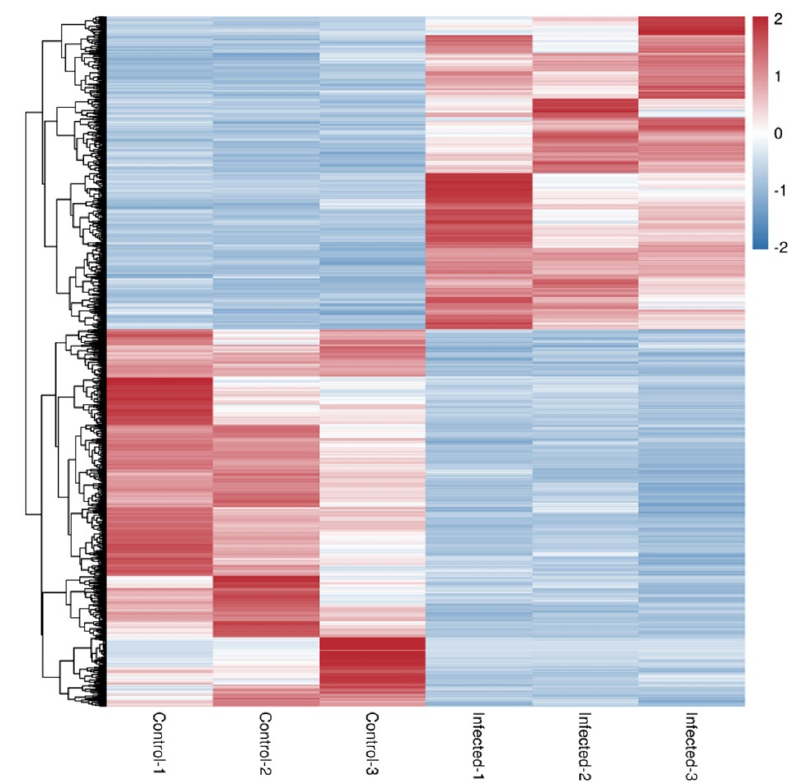
Figure 4. Heatmap of the differential gene expression. RNA-seq heatmap of the expression profile of the differentially expressed genes in control 1–3 and infected 1–3. The differential gene expression was presented under a false discovery rate (FDR) < 0.05. Overexpressed genes are shown in red and downregulated genes are shown in blue.